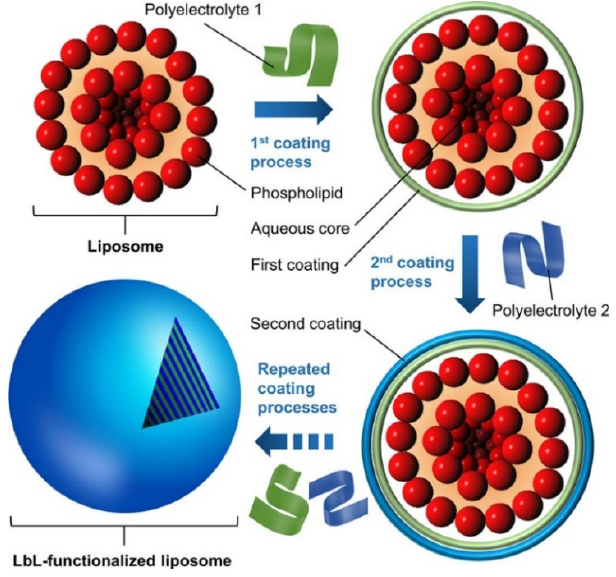
Figure 7. Sketch of the LbL approach for the fabrication of different LbL decorated liposomes. Reprinted with permission from reference [238]. Copyright (2020), with permission from the Ameri- can Chemical Society.